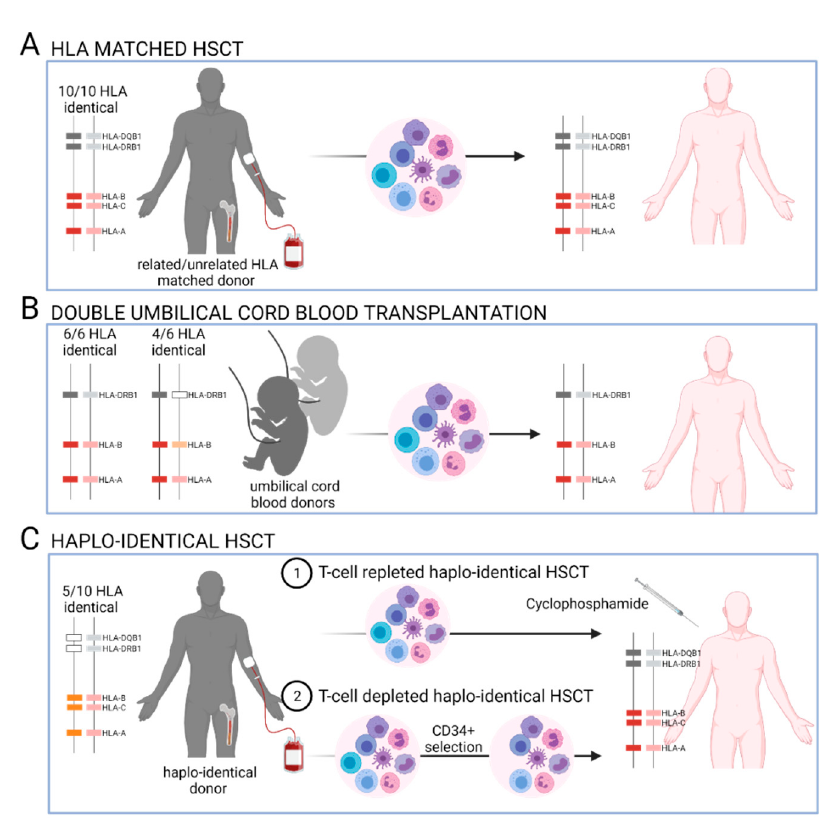
Figure 3. Donor/recipient HLA matching prior to allogeneic hematopoietic stem-cell transplantations (HSCT). The matching of the HLA-A, -B, -C, -DRB1, and -DQB1 genes between donors and recipients in both haplotypes is usually sought prior to related or unrelated HSCT ( A ). In the absence of related/unrelated 10/10 HLA-identical donors, double-umbilical cord blood transplantation (dUCBT) could be proposed so that only the matching of the HLA-A, -B, and -DR genes would be considered. In this context, the two UCB units and the recipient usually have 4/6 to 6/6 HLA matches ( B ). More recently, a donor with a 5/10 HLA-haplo-identical match is sought. The use of cyclophosphamide post-grafting as a prophylaxis against GvHD permits the deletion of the reconstitution of alloreactive T cells from T-repleted grafts ( C